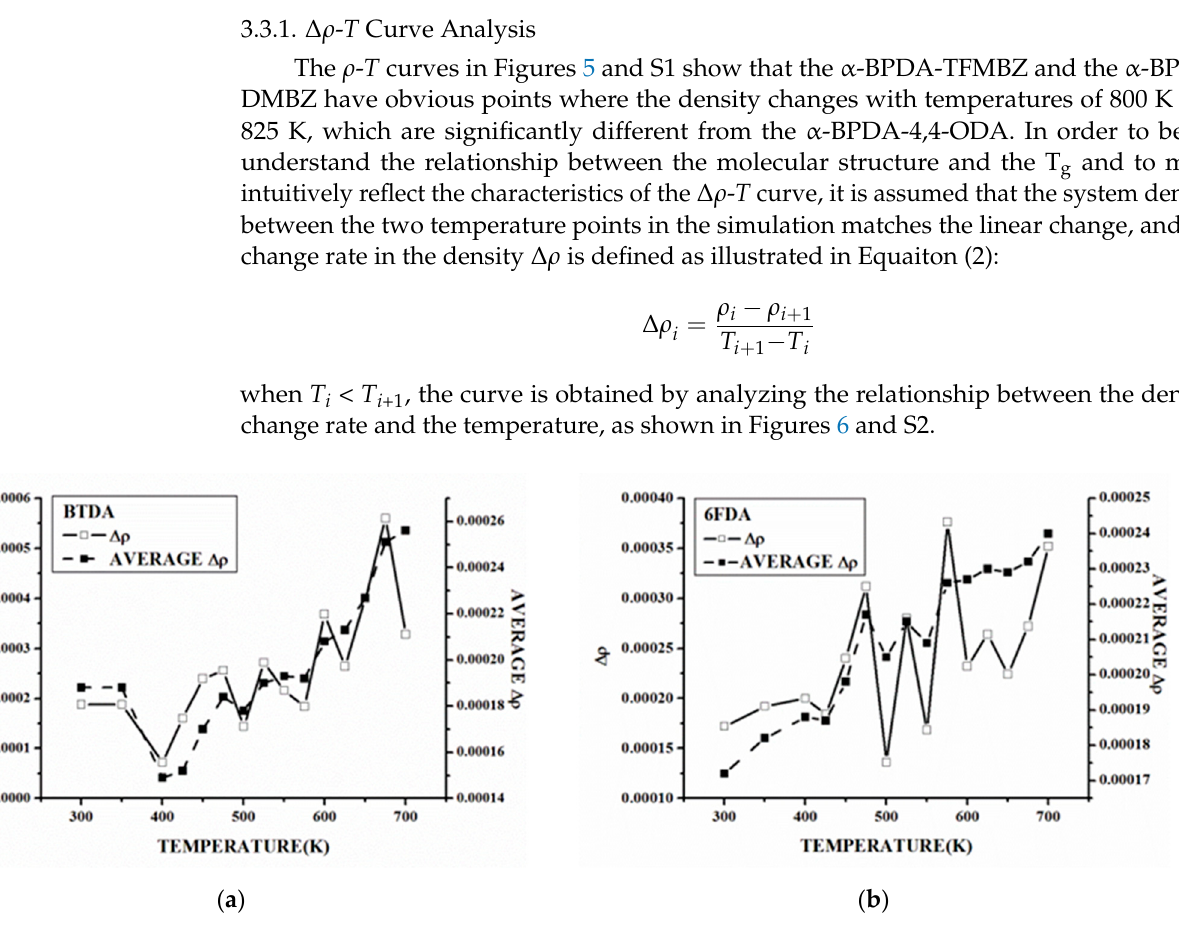
Figure 6. The Δρ - T curves and Δρ mean value curves with temperature of each system: ( a ) BTDA- Figure 6. The ∆ ρ - T curves and ∆ ρ mean value curves with temperature of each system: ( a ) BTDA-APB APB and ( b ) 6FDA-APB. and ( b )